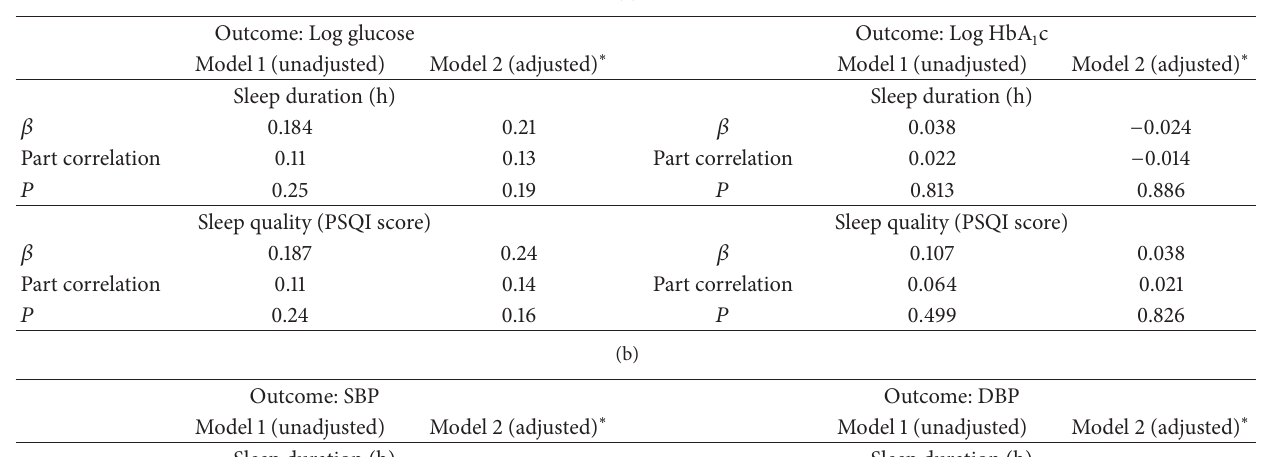
c (Table 3(a)), SBP and DBP 1